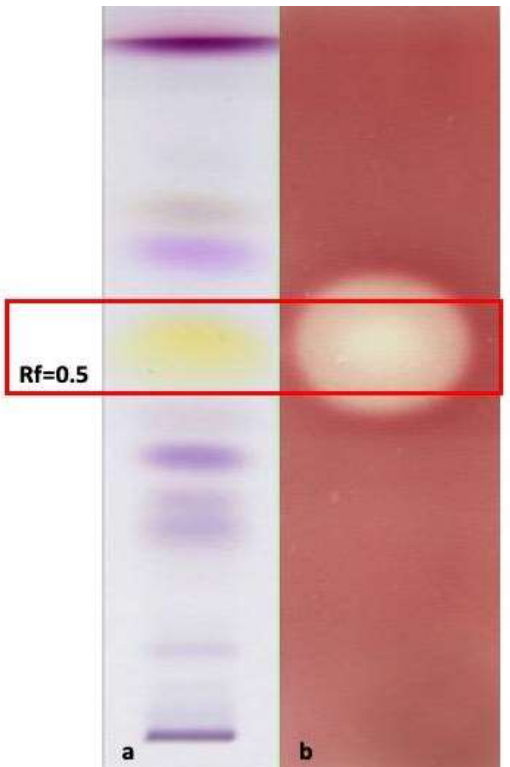
Figure 3. HP-TLC bioautographic assay showing the antimicrobial activity of O. campechianum EO, the most interesting among the EOs tested. The bioautographic plate ( b ) shows the bleaching band (microbial growth inhibition zone) of the antimicrobial activity against Klebsiella oxytoca , the most sensitive bacterial strain with the lowest MIC detected (0.75 mg/mL), at Rf = 0.5, corresponding to eugenol, the compound responsible of the bioactivity for O. campechianum EO. ( a ) Plate eluted and treated with vanillin sulphuric acid reagent; ( b ) plate eluted and treated with K. oxytoca for the antimicrobial bioautographic evaluation. Table 5. Antimicrobial activities of EOs from the studied species compared with that of commercial T. vulgaris . Chloramphenicol ( CPh ) and fluconazole ( Flu ) were used to test the sensitivity of bacterial and yeast strains respectively.